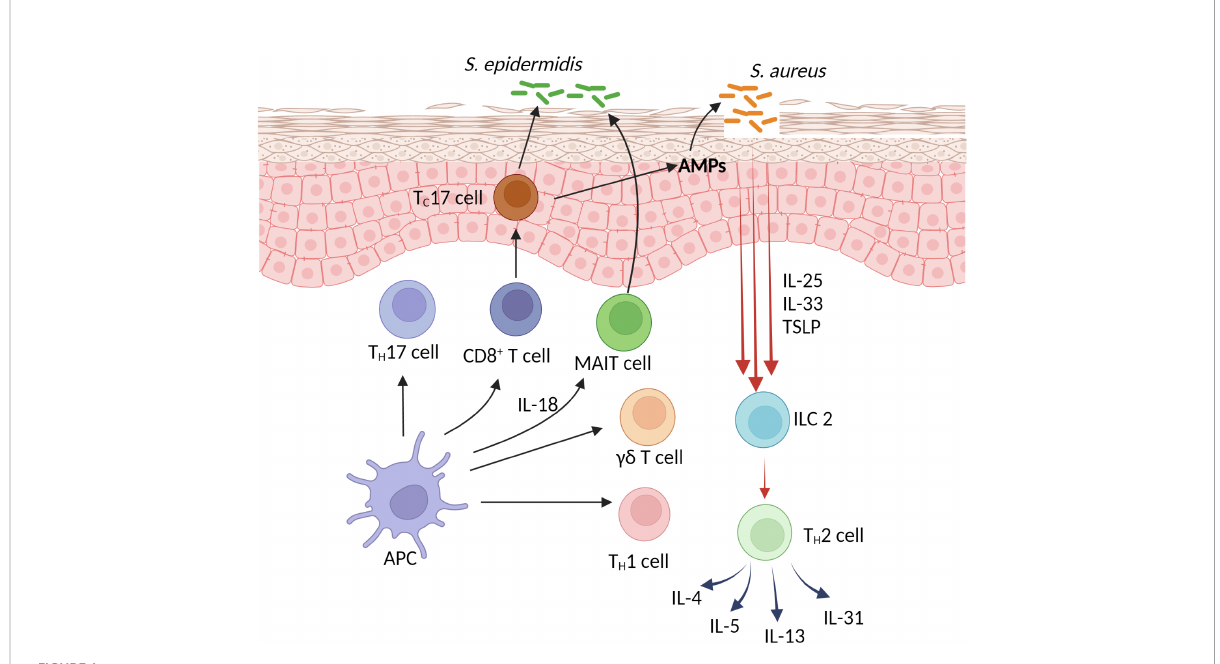
FIGURE 1 Skin barrier defense and the pathogenesis of atopic